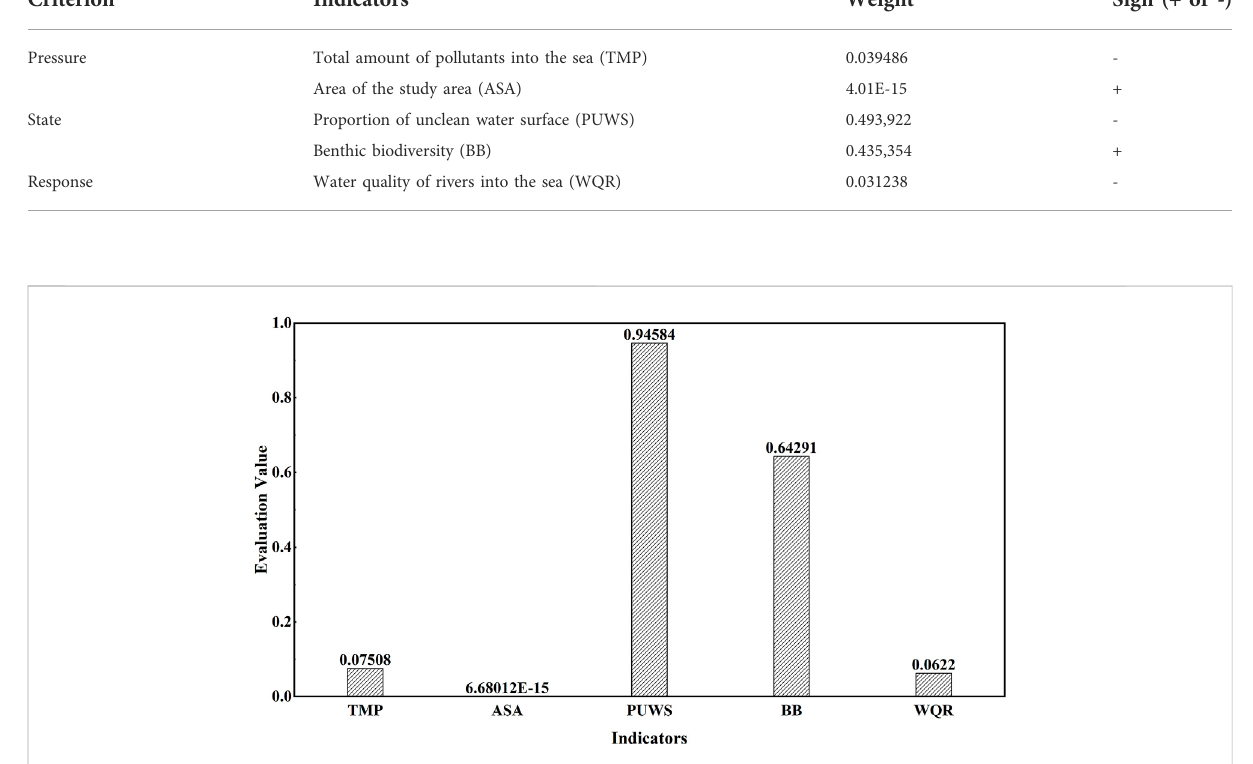
TABLE4Relativeimportance(i.e.,weight)ofindicatorsinthepressure-state-responsemodeldeterminedthroughtheentropyweightmethod(EWM) for the study site. Criterion